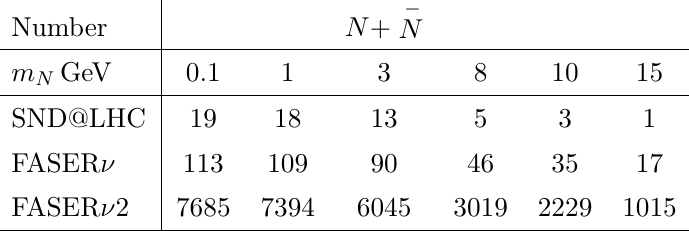
Table 1 . The total predicted numbers of N + run III of the LHC as well as by FASER ν 2 during HL-LHC era, taking G and different values of m